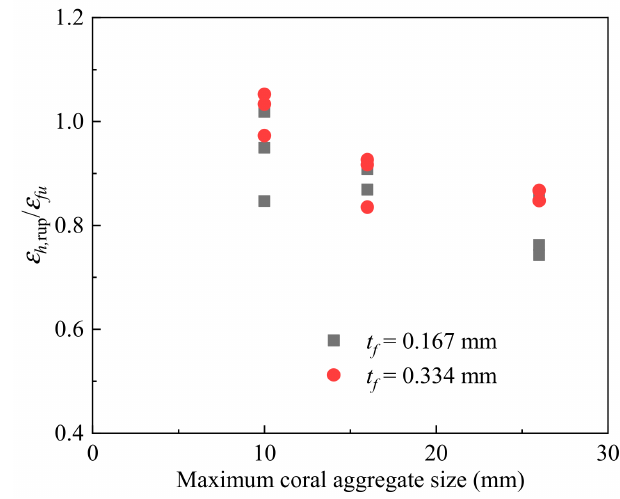
Figure 8. Effect of coral aggregate size on ultimate lateral strain.